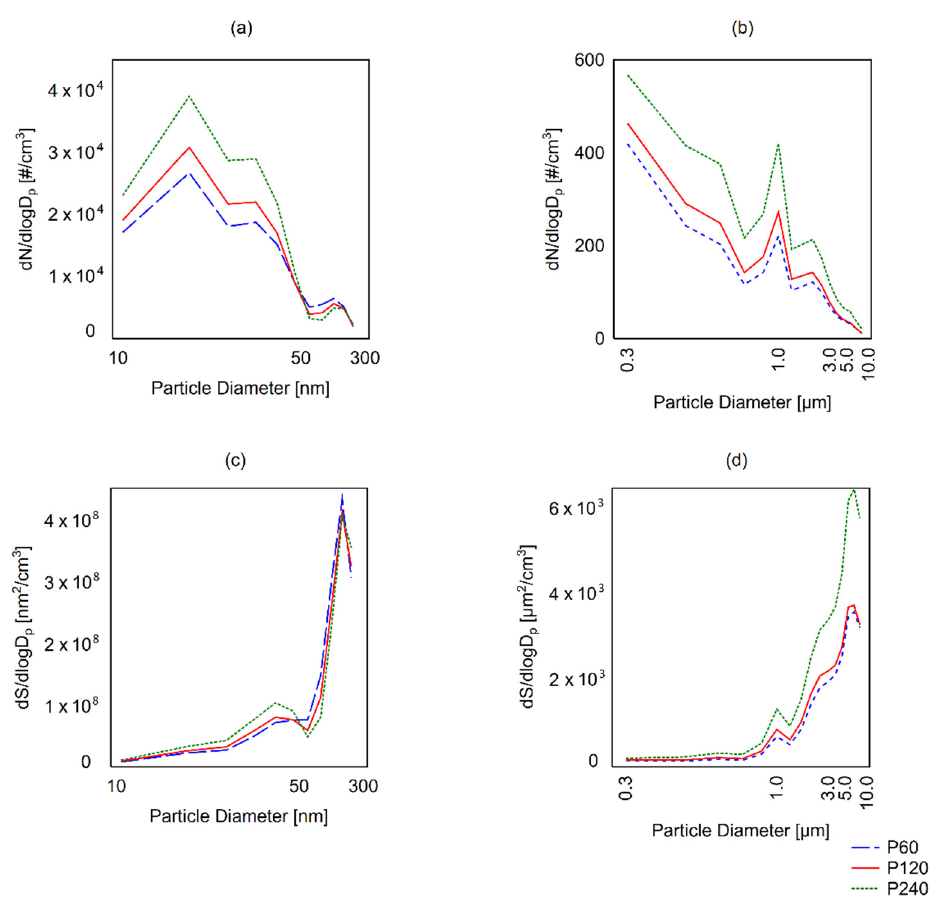
Figure 4. Particle size distributions generated by grits P60, P120, and P240: ( a ) Normalized number concentration measured with NanoScan SMPS; ( b ) Normalized number concentration measured with OPS; ( c ) Normalized surface area concentration (LDSA) measured with NanoScan SMPS; ( d ) Normalized surface area concentration (LDSA) measured with OPS.